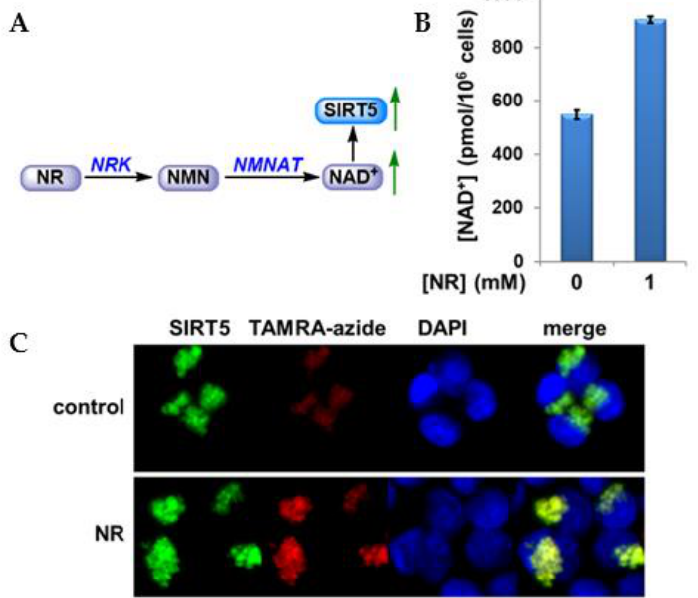
Figure 7. In-cell labeling of SIRT5 with probe 2B. ( A ). Nicotinamide riboside (NR) pathway; ( B ). Cellular NAD + concentrations; ( C ) HEK293 cells overexpressing SIRT5 and treated with NR showed increased labeling intensity compared with control cells.